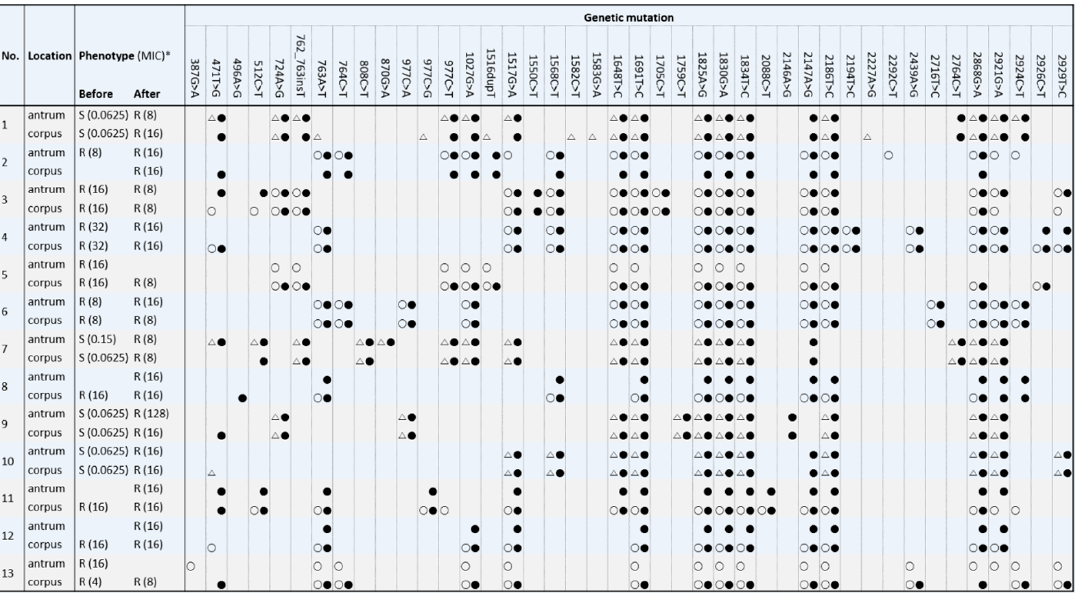
Figure 1. Phenotypic antimicrobial resistance to clarithromycin based on minimum inhibitory concentration (MIC) and genetic mutation in 23S rRNA genes of 46 H. pylori strains from 13 subjects, before (open symbol) and after (closed symbol) unsuccessful eradication therapy with clarithromycin-based triple therapy. Phenotypic resistance was classified as resistant (R, circle) or susceptible (S, triangle) based on MIC breakpoint of > 0.5 µ g / mL. * Numbers in parentheses indicate MIC ( μ g/mL).